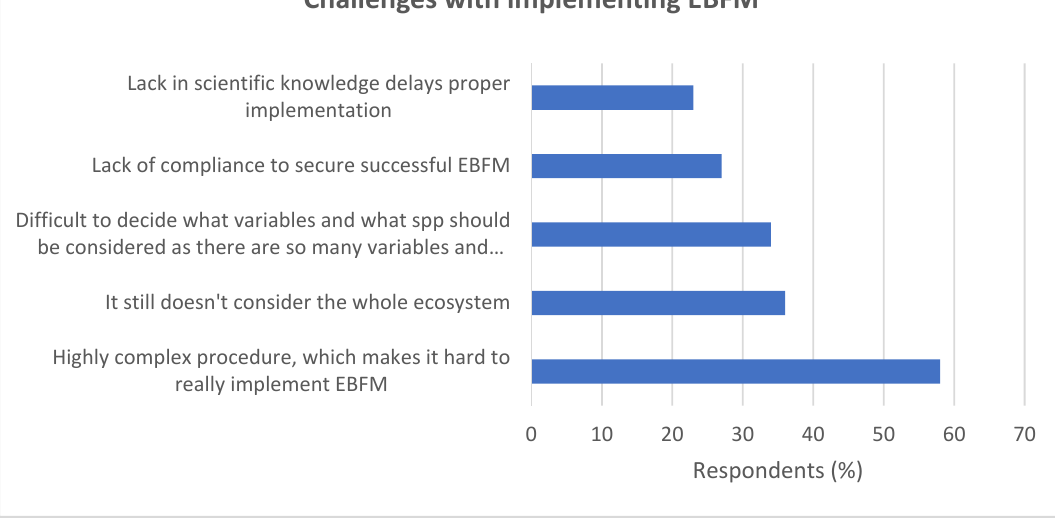
Figure 11. Implementing EBFM is a complex task (n = 83).